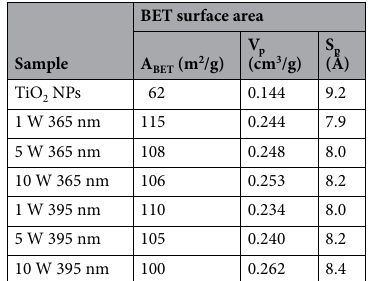
Table 1. Low-temperature N 2 sorption results including BET surface area, pore volume, and diameter for synthesized TiO 2